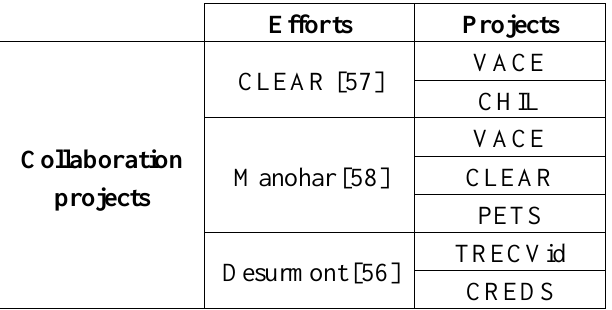
Table 4. Past efforts on the collaboration of different